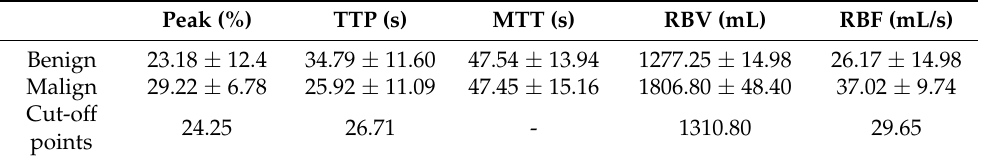
Table 2. CEUS quantitative parameters and cut-off points for distinguishing between benign and malignant